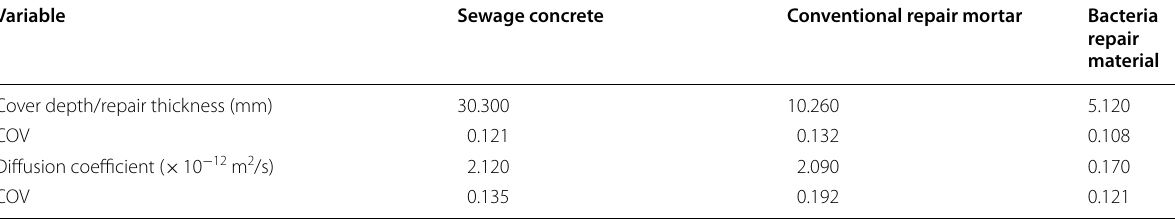
Table 2 Random variable derivation of diffusion coefficient and cover